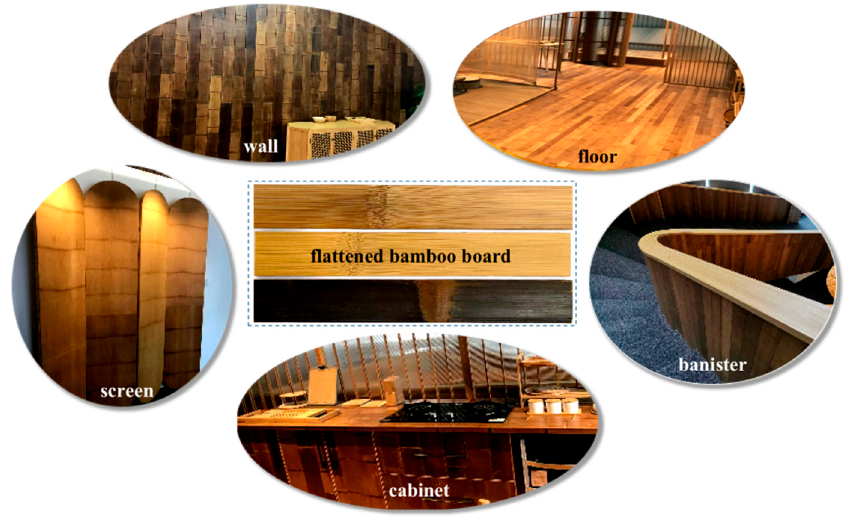
Figure 1. Applications of the flattened bamboo board in interior decoration and